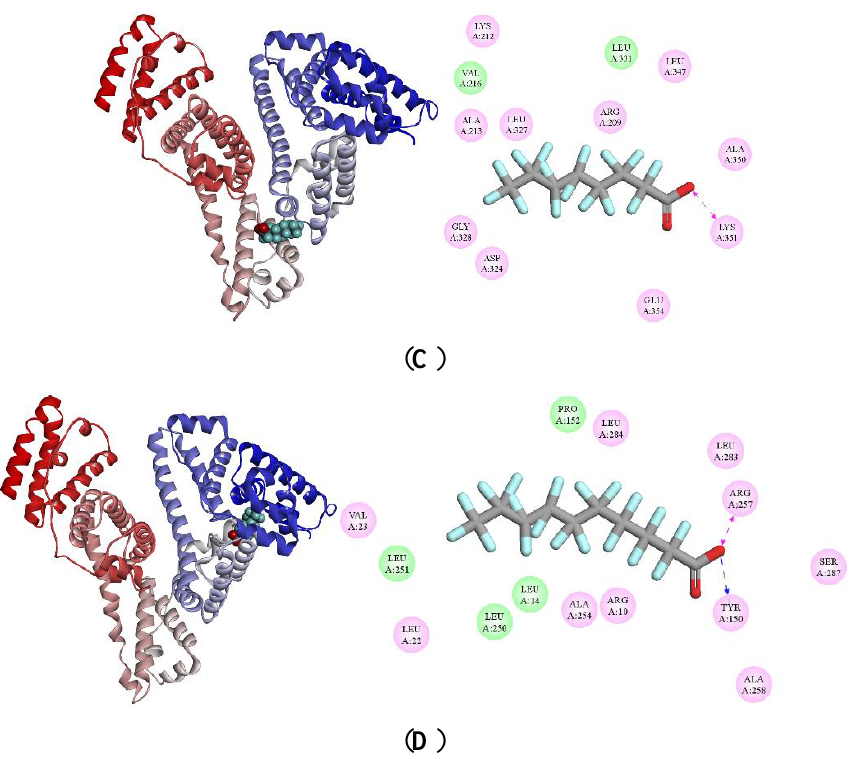
Figure 5. Left: Binding site of PFCAs on HSA (PDB ID: 1H9Z). HSA is shown in cartoon. PFCAs are represented using spheres. Right: 2D ligand interaction diagram of PFCAs with HSA using Discovery Studio with the essential amino acid residues at the binding site tagged in circles. Pink circles show the amino acids that participate in electrostatic interactions, and green circles show the amino acids that participate in van der Waals interactions. Hydrogen-bond interactions with amino acid side-chains (blue dashed arrow) and charge interactions (pink dashed arrow) are indicated. ( A ) PFBA–HSA; ( B ) PFHxA–HSA; ( C ) PFOA–HSA; and ( D ) PFDA–HSA.